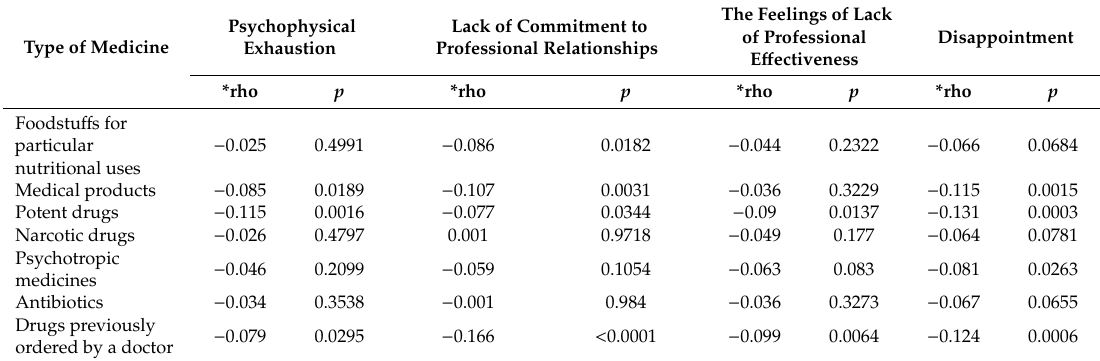
Table 6. Nurses’ self-assessed preparedness for prescribing and their level of occupational burnout (as assessed by LBQ).